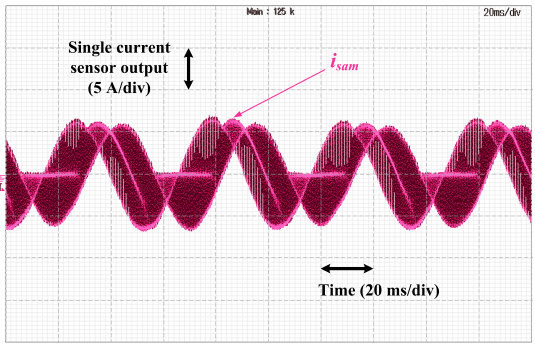
Figure 11. The single current sensor outputs; time scale: 20